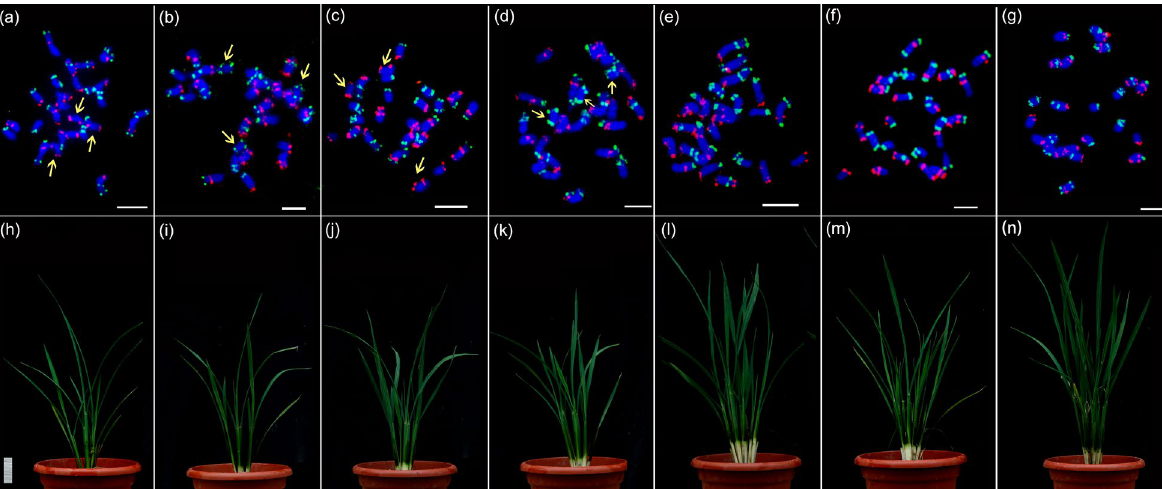
Fig. 1 Fluorescence in situ hybridization (FISH) identification of aneuploid and diploid on mitotic metaphase chromosomes in rice. a and b Bar-code oligo-FISH analysis of parental primary trisomy 11 and 12 (named as T11-P and T12-P) using FAM-green and digoxigenin-red labeled probes on somatic cell chromosomes in mitotic metaphase, respectively. c and d Bar-code oligo-FISH analysis of filial primary trisomy 11 and 12 (named as T11-F and T12-F) using FAM-green and digoxigenin-red labeled probes on somatic cell chromosomes in mitotic metaphase, respectively. e and f FISH analysis of normal strain of progeny of parental primary trisomy 11 and 12 (named as T11-FN and T12-FN) using FAM-green and digoxigenin-red labeled probes on mitotic metaphase chromosomes, respectively. g FISH analysis Zhongxian 3037 using FAM-green and digoxigenin-red labeled probes on mitotic metaphase chromosomes. h–n The seedling phenotype corresponding to ( a–g ). Bars arrow points to the extra chromosomes. Chromosomes were counterstained with 4’,6-diamidino-2-phenylindole. Bars